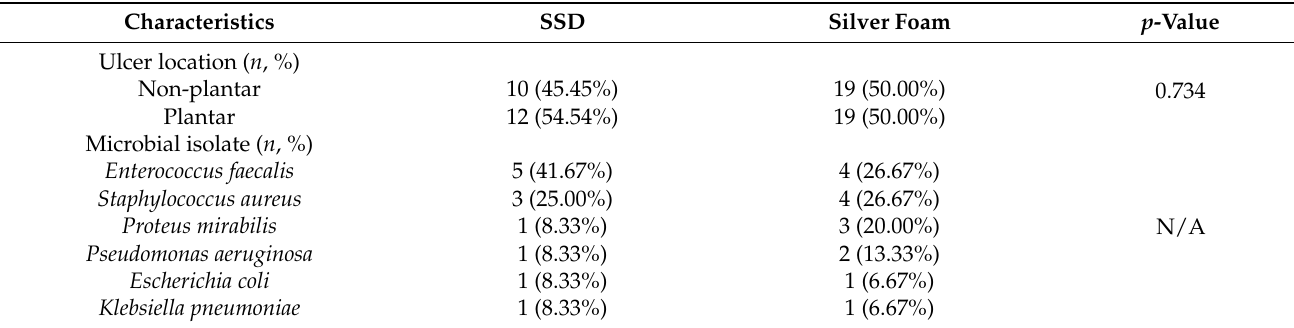
Table 3. Analysis of the predisposing factors and wound healing in both groups . Predisposing Factors